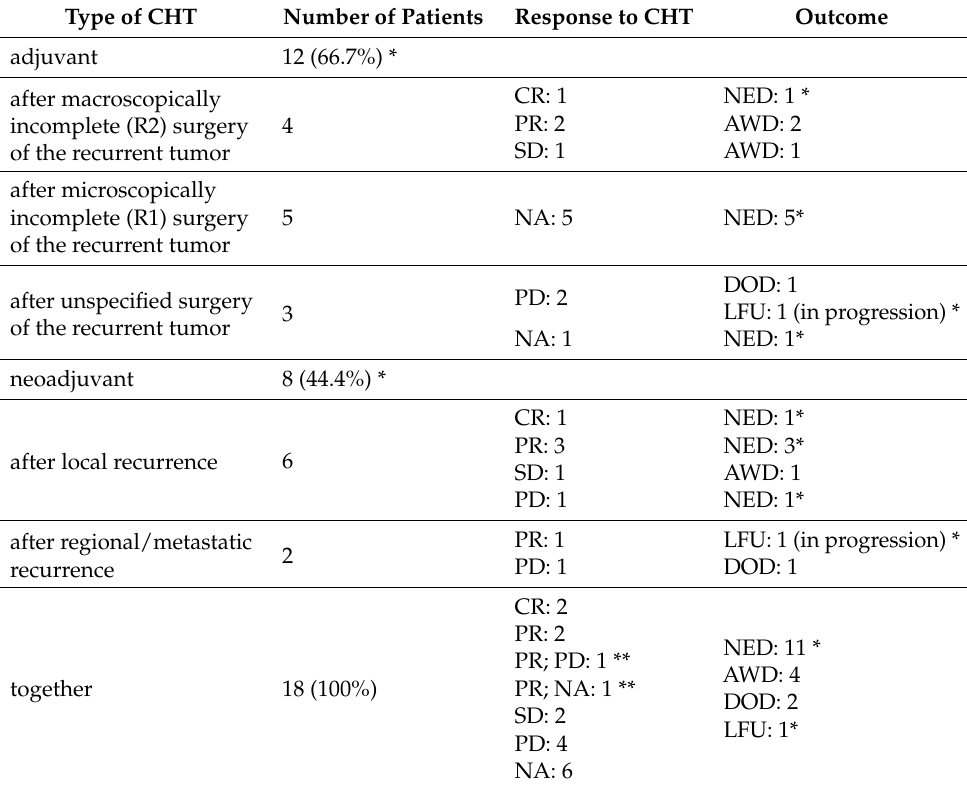
Table 7. Summary data of the patients receiving CHT in the treatment of recurrent MNTI (n = 18). Type of CHT Number of Patients Response to